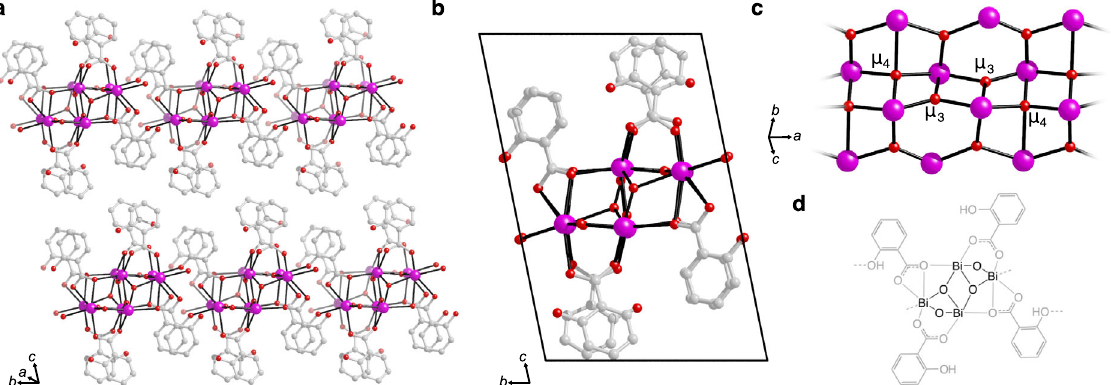
Fig. 2 The crystal structure of bismuth subsalicylate. a Stacking of the layers found in the BSS structure. Bi-O bonds are drawn as black lines. Hydrogen atoms have been omitted for clarity. b The unit cell of BSS viewed down the a -axis. c A section of the bismuth-oxo rod forming the inorganic building unit which includes O 2- anions coordinated to alternatingly three and four Bi 3 + cations, µ 3 and µ 4 , respectively. d A molecular sketch of a section of the BSS structure with bonds along the rod omitted for clarity.